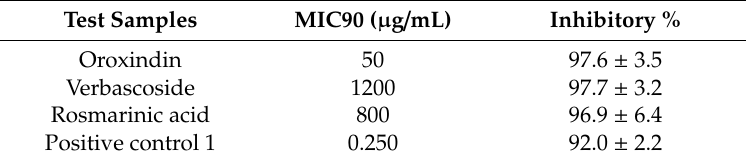
Table 2. Minimum inhibitory concentration (MIC) values and inhibition percentage of test samples for ATCC-43504. Test Samples MIC90 ( µ g / mL)